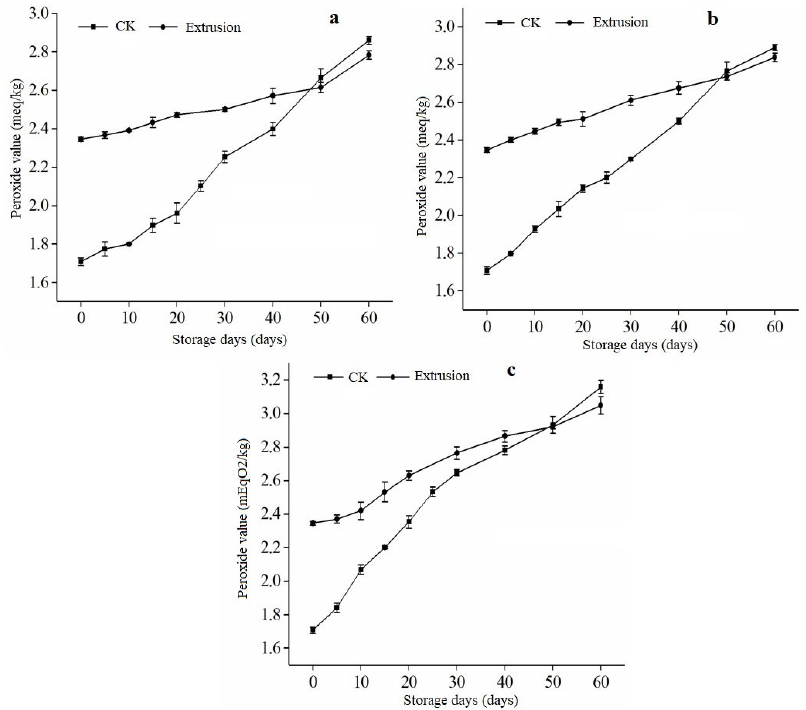
Figure 5 . Changes in peroxide value of rice bran treated by extrusion. Note; a , b , and c in the figure refer to the storage temperature of 15 °C, 25 °C, and 40 °C; CK is untreated rice bran. to the storage temperature of 15 ◦ C, 25 ◦ C, and 40 ◦ C; CK is untreated rice